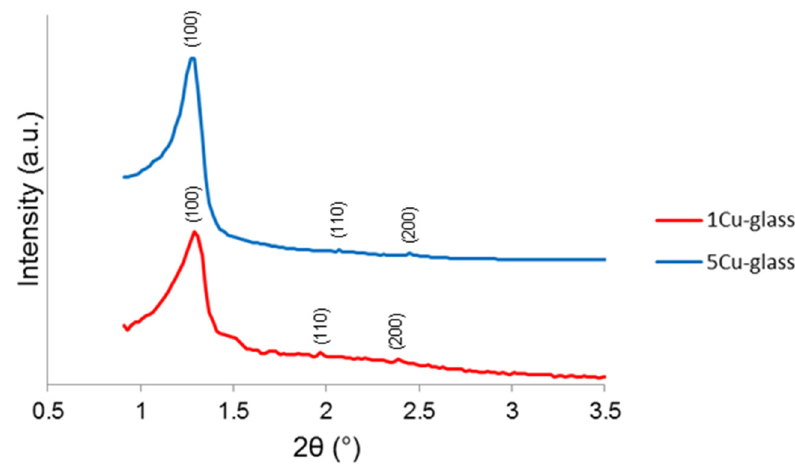
Figure 3. Small-angle XRPD patterns of copper-doped materials after calcination.